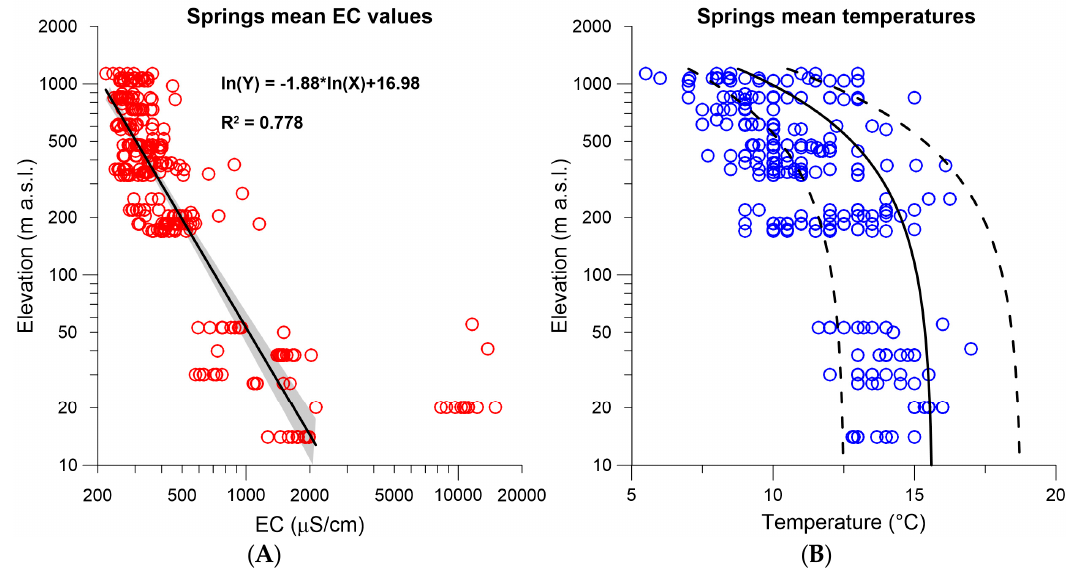
Figure 5. ( A ): altitude versus springs EC mean values during the monitoring period (2002–2017); the black line represents the EC–altitude power–law relationship found, excluding the highly mineralized springs (EC > 5000 µS/cm), and the grey shaded area shows the 95% confidence intervals. ( B ): altitude versus springs mean temperatures during the monitoring period (2002–2017); the black curve represents the temperature–altitude gradient [41], and the dashed curves a temperature variability of ±20%.